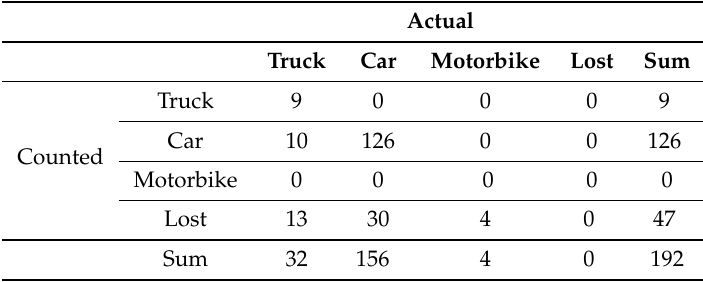
Table 10. Counting results per vehicle type from a highway with 1500 ms request